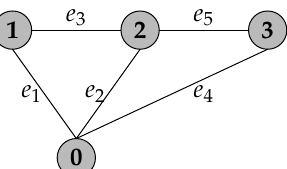
Figure 3. The graph model G ( V , E ) of the airport terminal. The targets correspond to the targets as shown in Figure 1.